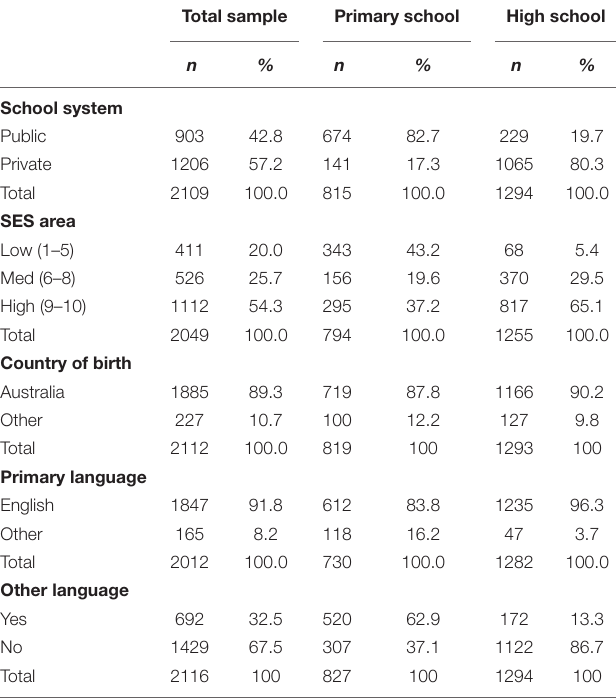
TABLE 1 | Distribution of sociodemographic characteristics in the